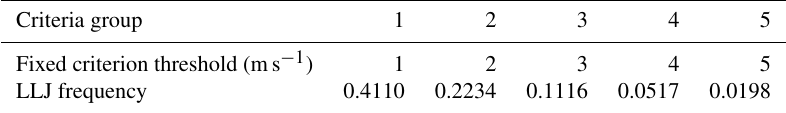
Table 3. Marginal probabilities of LLJs when each of the fixed selection criteria are applied. Results are shown for hourly wind speed profiles from the single grid cell of highest LLJ frequency according to the seasonal study previously developed.